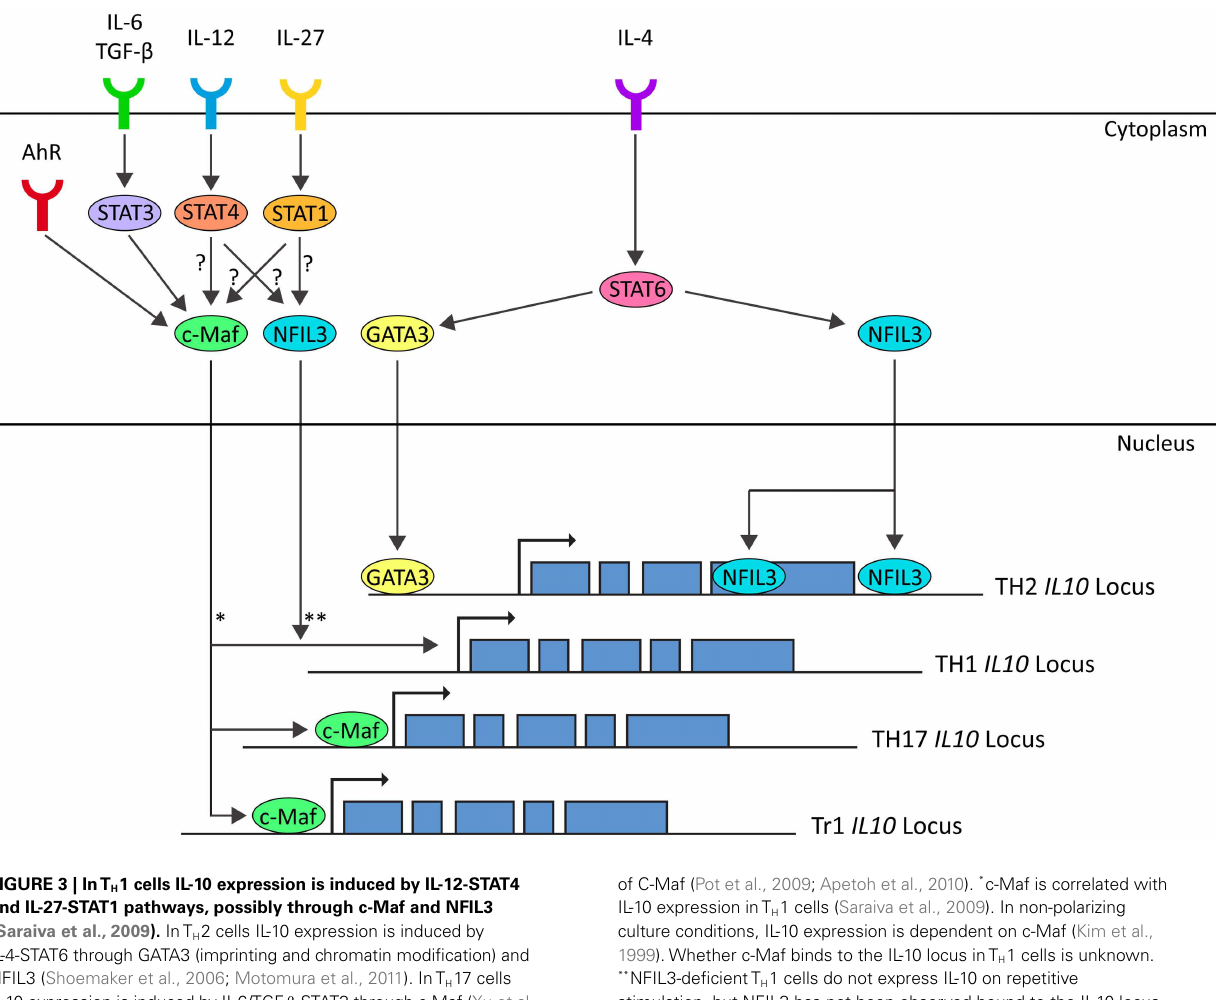
** NFIL3-deficientT H 1 cells do not express IL-10 on repetitive stimulation, but NFIL3 has not been observed bound to the IL-10 locus inT H 1 cells. (Motomura et al.,